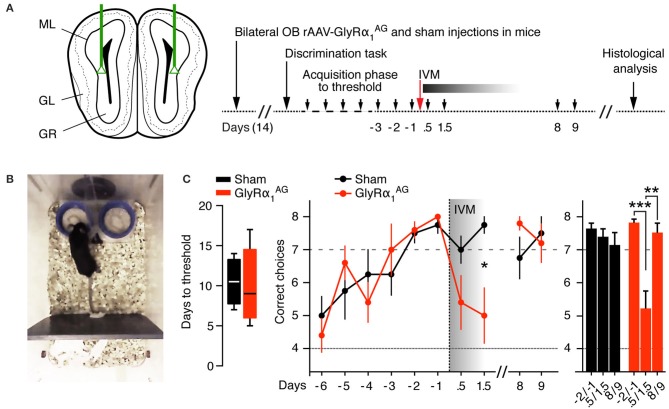
IVM induced GlyRα1AG activation in the olfactory bulb lead to a deficit in odor discrimination. (A) Left: Scheme of bilateral stereotactic rAAV-syn-GlyRα1AG-2A-Venus and sham (PBS) injections into the OB. Right: Time line of the experiment. Small black arrows indicate days on which olfactory discrimination testing was performed. (B) Picture of the apparatus used in the discrimination test; the lids (blue) were scented with two odors of which only one was rewarded; both lids could be quickly removed from the apparatus if mice started to dig on the side with the wrong odor. (C) Left: The number of days in the acquisition phase required to reach the threshold criterion did not differ significantly in between groups (median, 25th/75th percentile, p > 0.05). Middle: 0.5–1.5 days after IVM injection, GlyRα1AG expressing mice performed worse than on the 3 days prior to injection and compared to sham injected mice; mice recovered from this deficit 8 days after IVM injection. Right: Comparison of pairs of test days, each: -2 d and -1 d prior to, 0.5 d and 1.5 d after, and +8 d and +9 d after, IVM injection; GlyRα1AG
n = 5, Sham n = 4. Data shown as means ± SEM; *p < 0.05, **p < 0.01, ***p < 0.001.